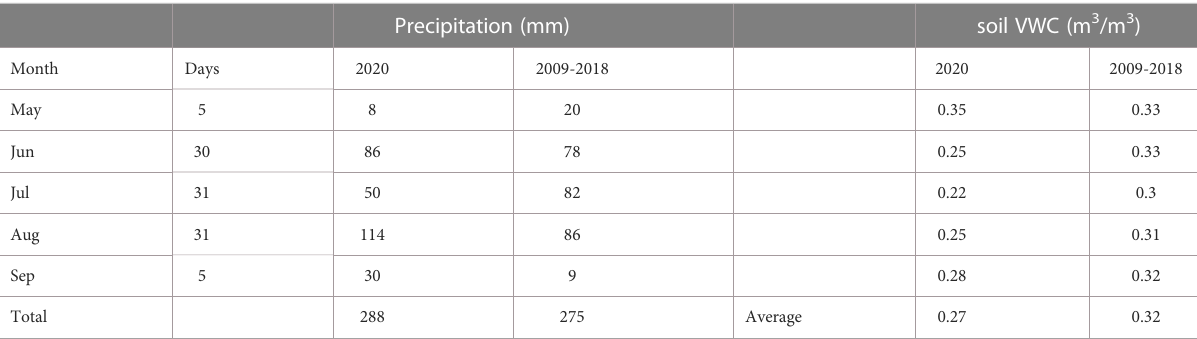
TABLE 1 Total monthly precipitation (mm) and soil volumetric water content (VWC; m3/m3) in 2020 at the rainfall exclusion shelters Biofuel Cropping System Experiment (42.394290, -85.374126) and historic record (2009-2018) between shelter deployment (May 27th) and last sampling date (Sept